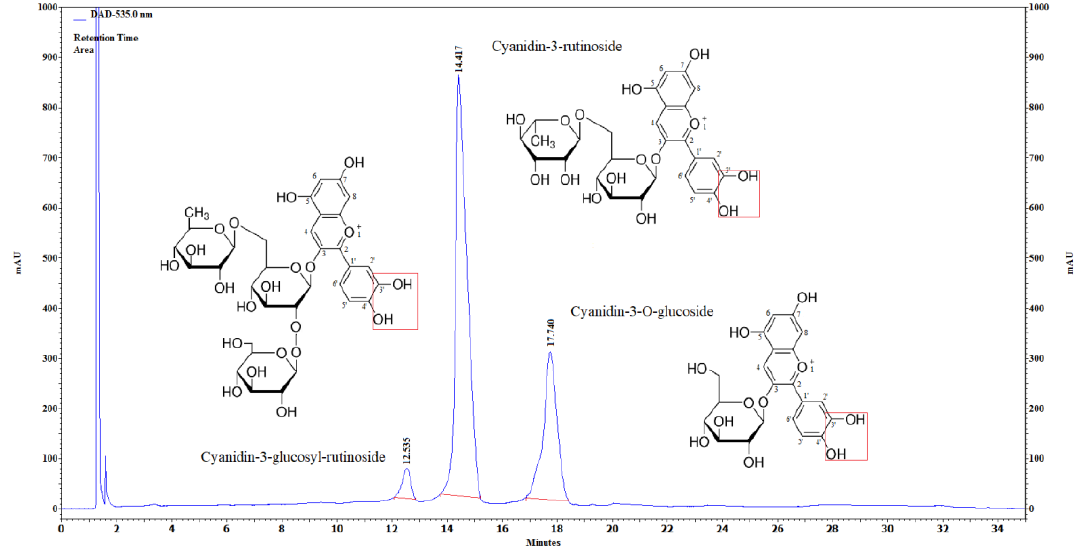
Figure 1. UHPLC chromatogram of sour cherry at 535 nm. Confirmed by standard.